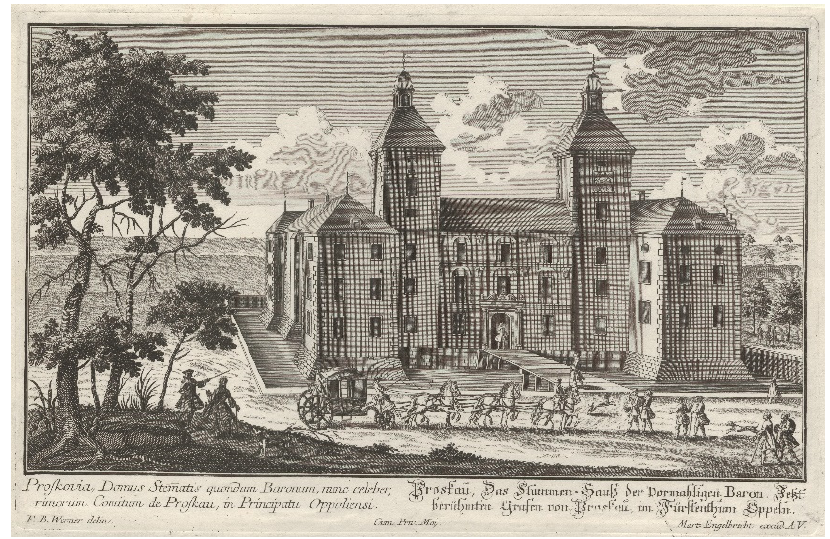
Figure 3. Prószków castle: view from the southeast from approximately 1735, drawn by Friedrich B. Werner; the lithography prepared by Martin Engelbrecht, source: © Österreichischen Nationalbibliothek, signature: KAR0512490, used with permission.